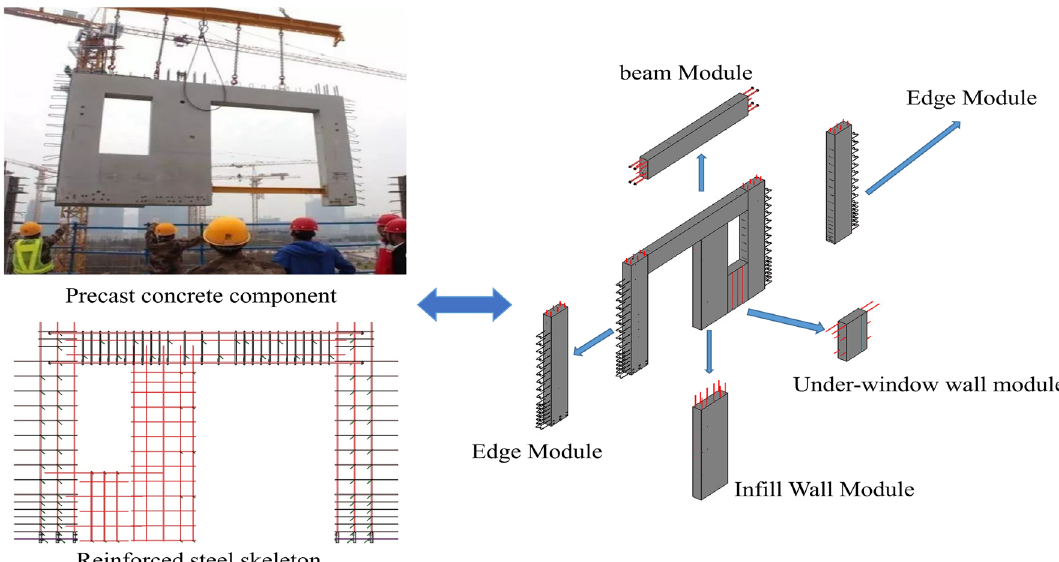
Figure 3. The secondary splitting modularity of the PC